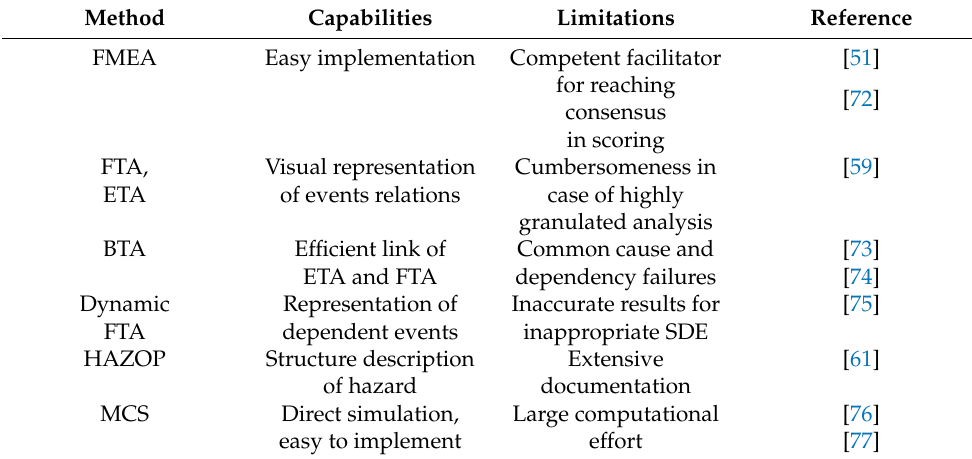
Table 2. A comparison between the main reliability methods.